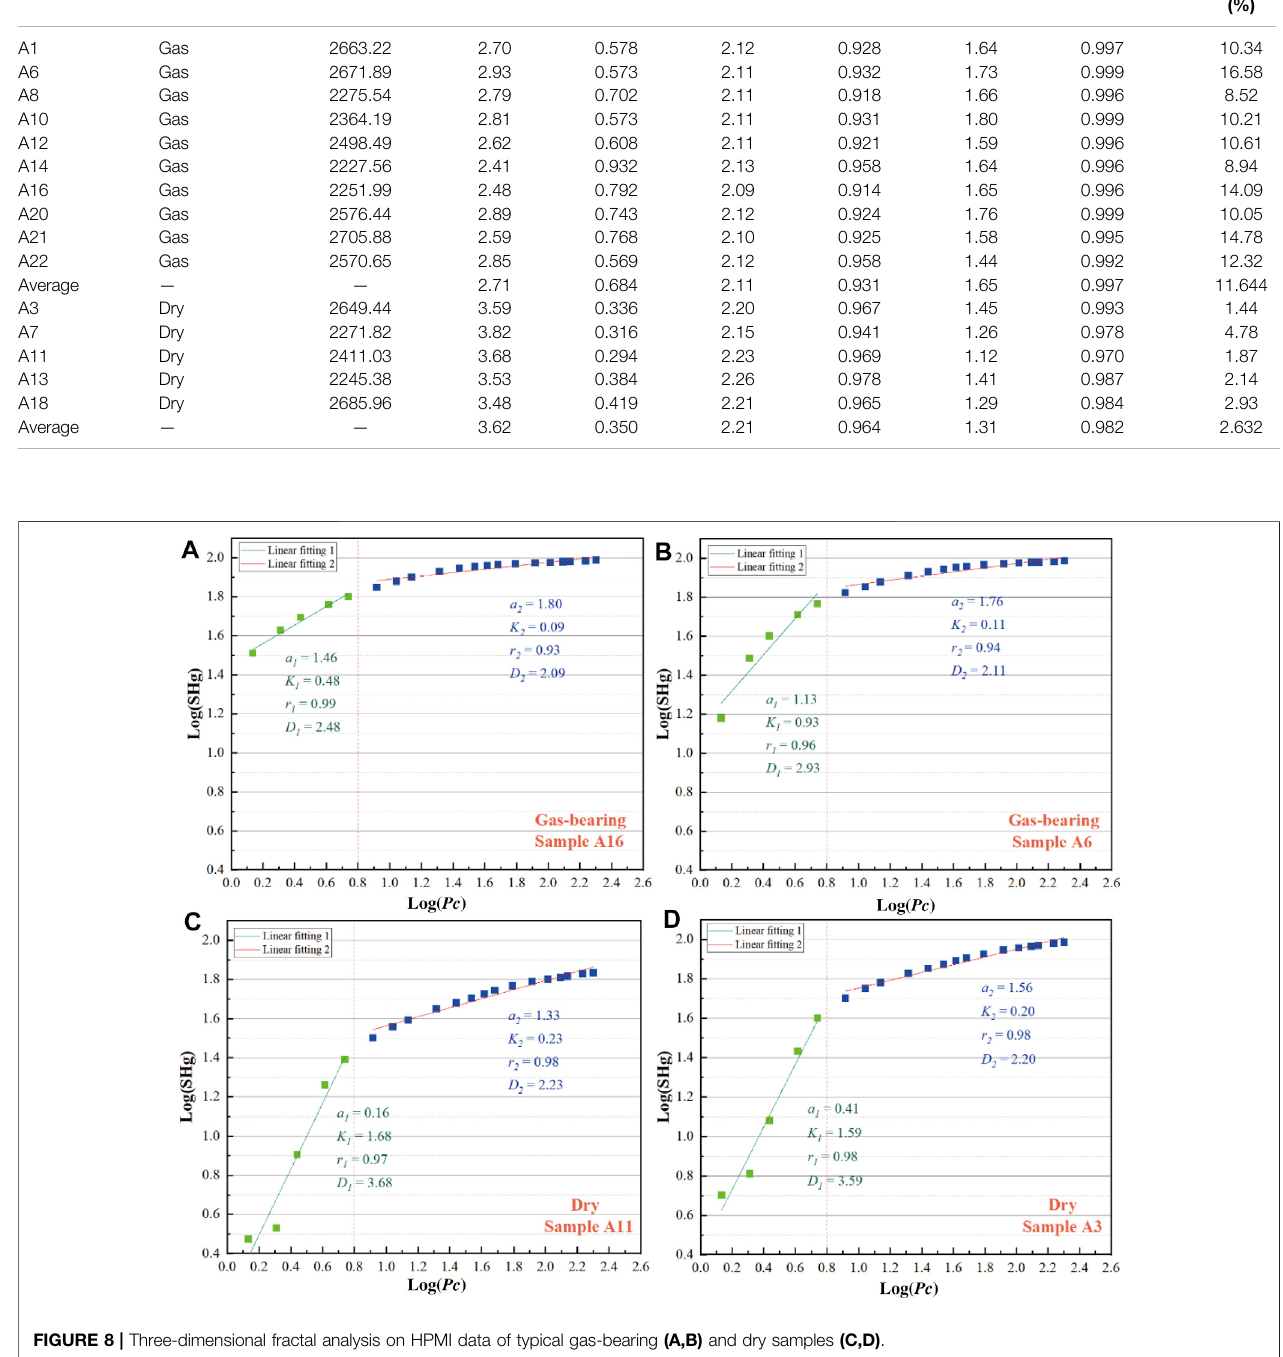
Frontiers in Earth Science |